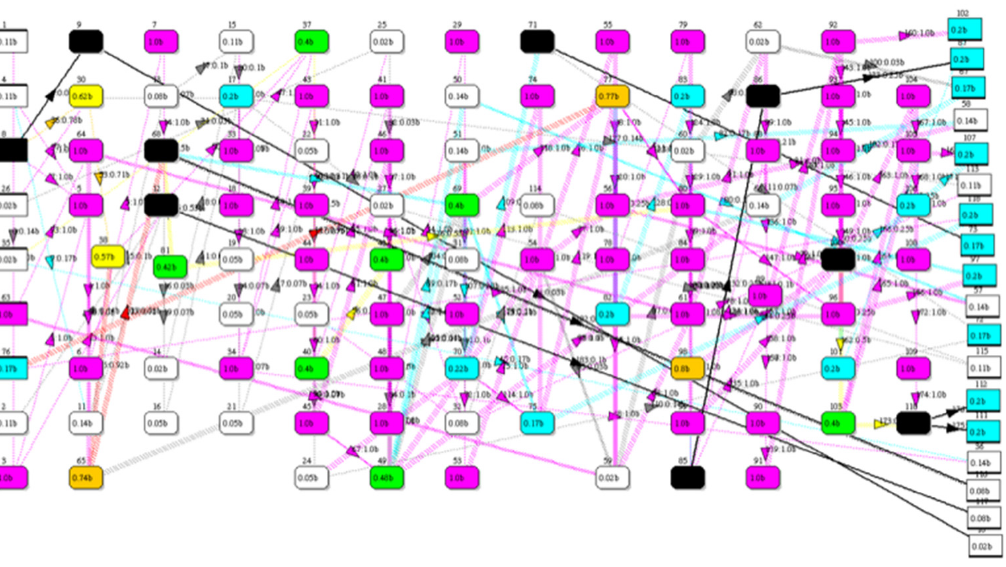
Figure 6. Heat map of IEEE-118 power grid test network with n + m = 304; the 9 blocking nodes and 9 blocking links are colored black, and all other nodes/links are assigned a bottleneck rating from 0 to 1.0 (and color code) based on their network topological betweenness. The network is drawn with sources on the left and sinks on the right.